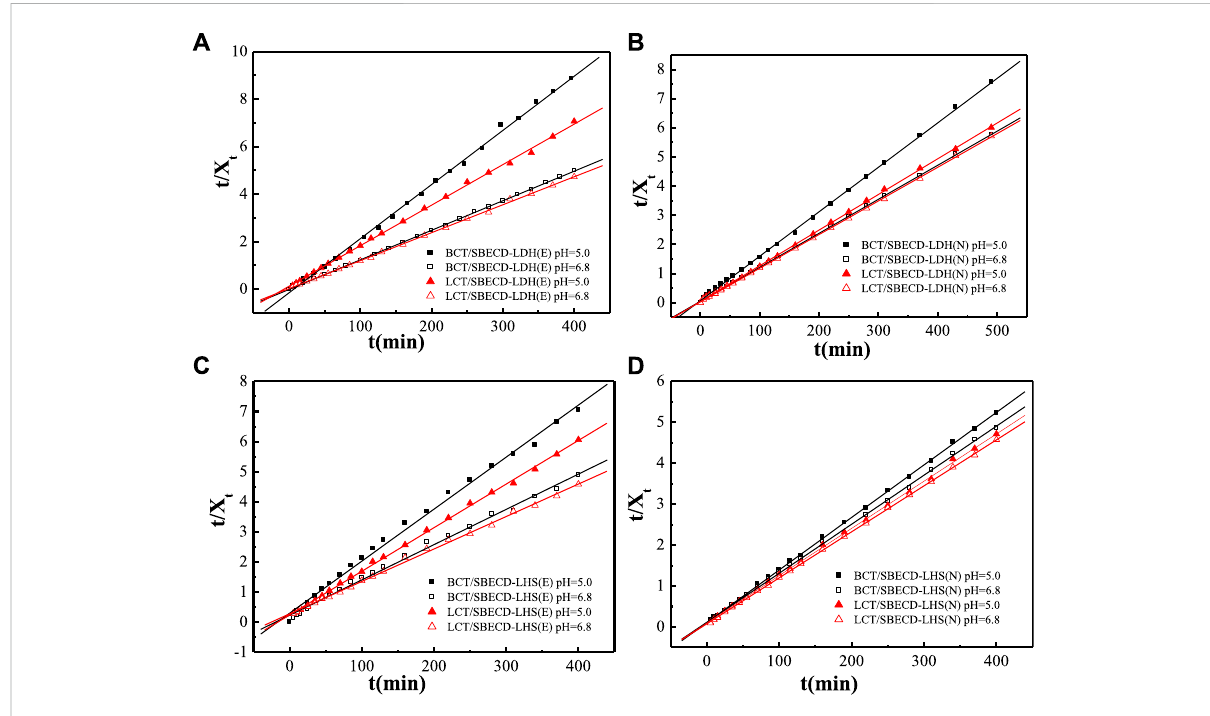
FIGURE 8 Regression curves of release data fi tting with pseudo second-order model for LDH-hybrids (A,B) and LHS-hybrids (C,D) in different